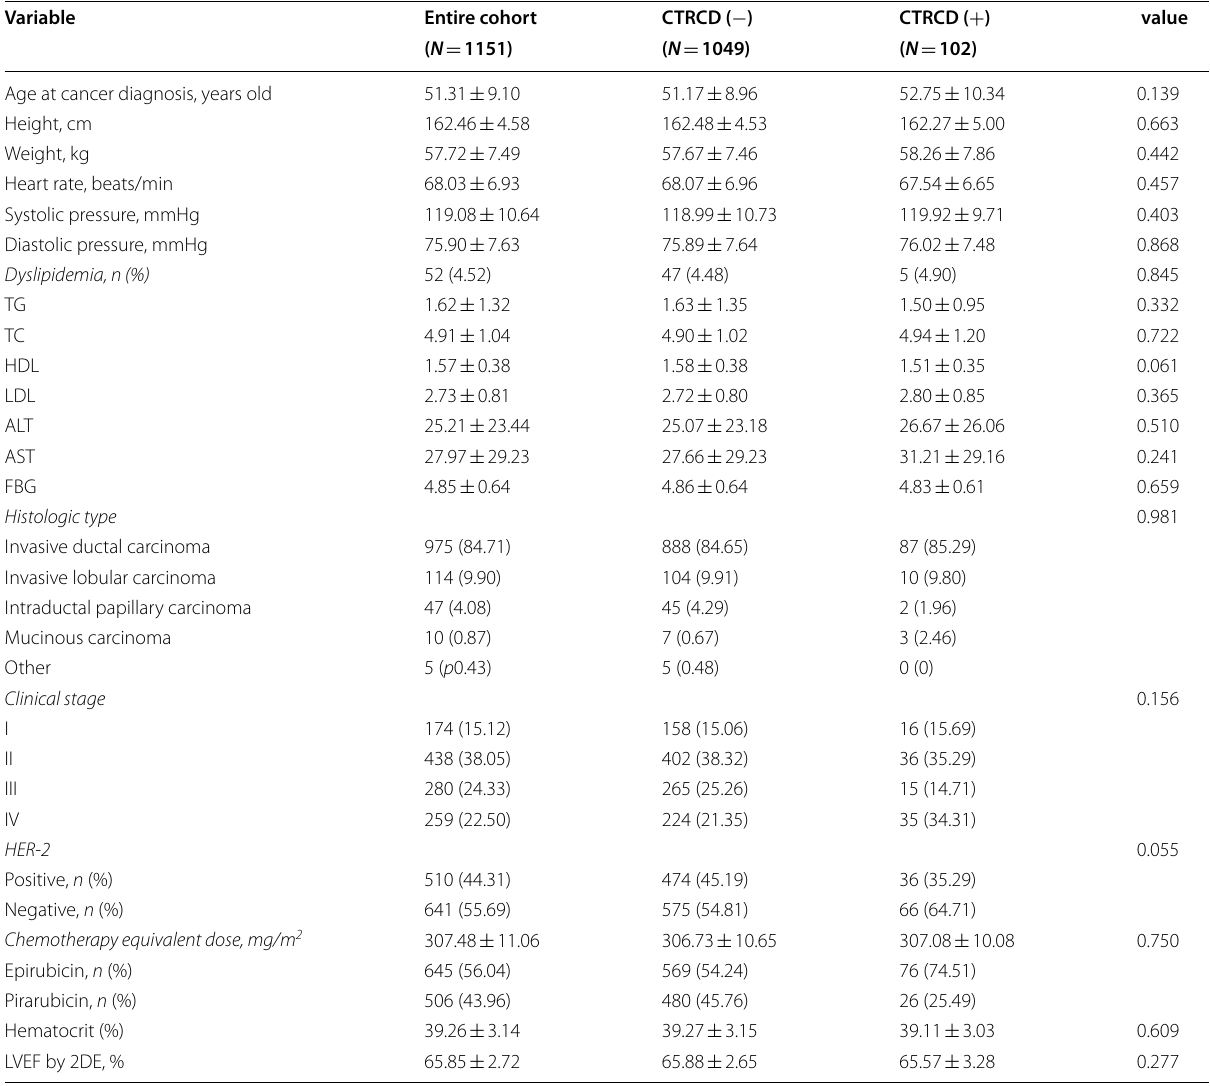
Table 1 Baseline characteristics of the study